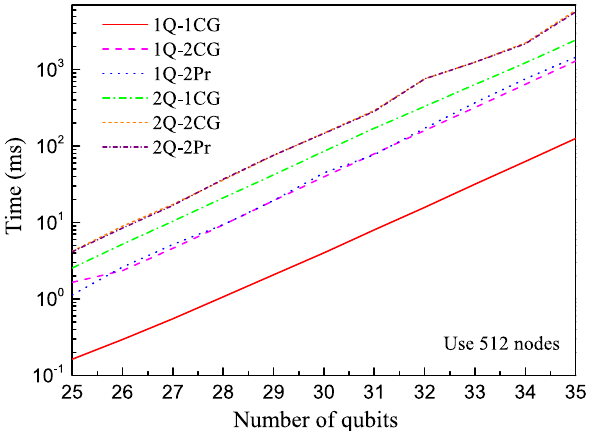
Figure 4. The time span of performing one- and two-qubit gates in different cases on the full amplitude mode. 1Q-1CG means that a one-qubit gate acts on a state stored in one core-group. 1Q-2CG means that a one-qubit gate acts on a state stored in two different core-groups, but in the same SW26010 processor. 1Q-2Pr means that a one-qubit gate acts on a state stored in two SW26010 processors. 2Q represents the two-qubit gate.